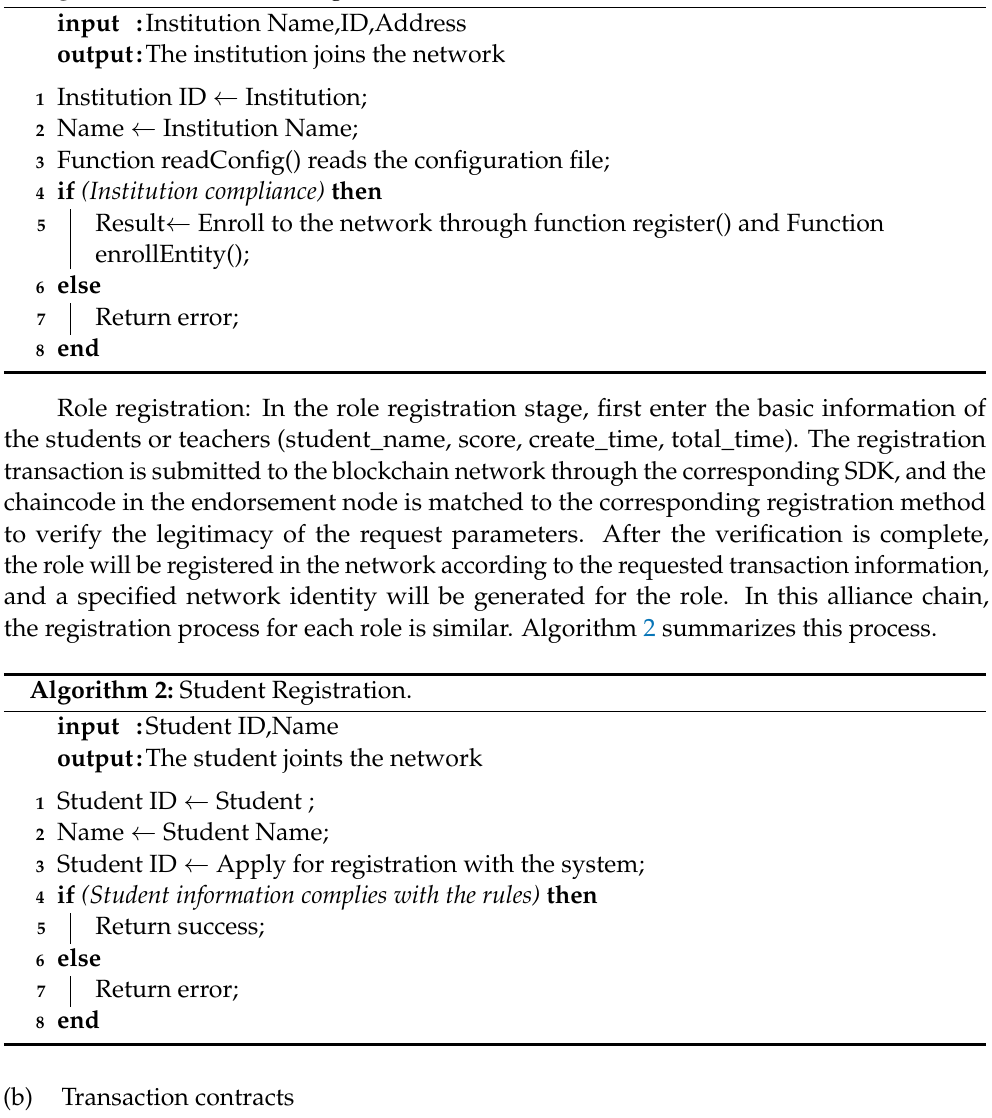
Algorithm 1: Institution